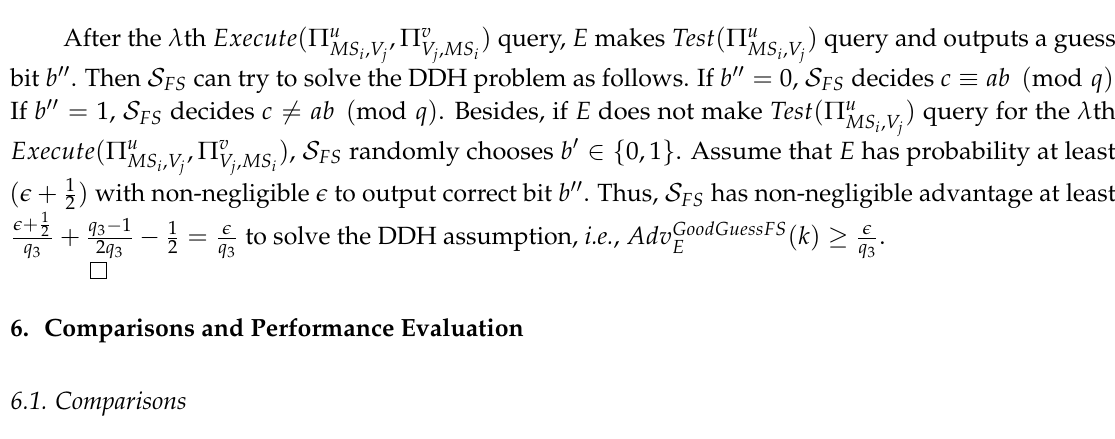
Figure 18. The oracles of the proof of Theorem